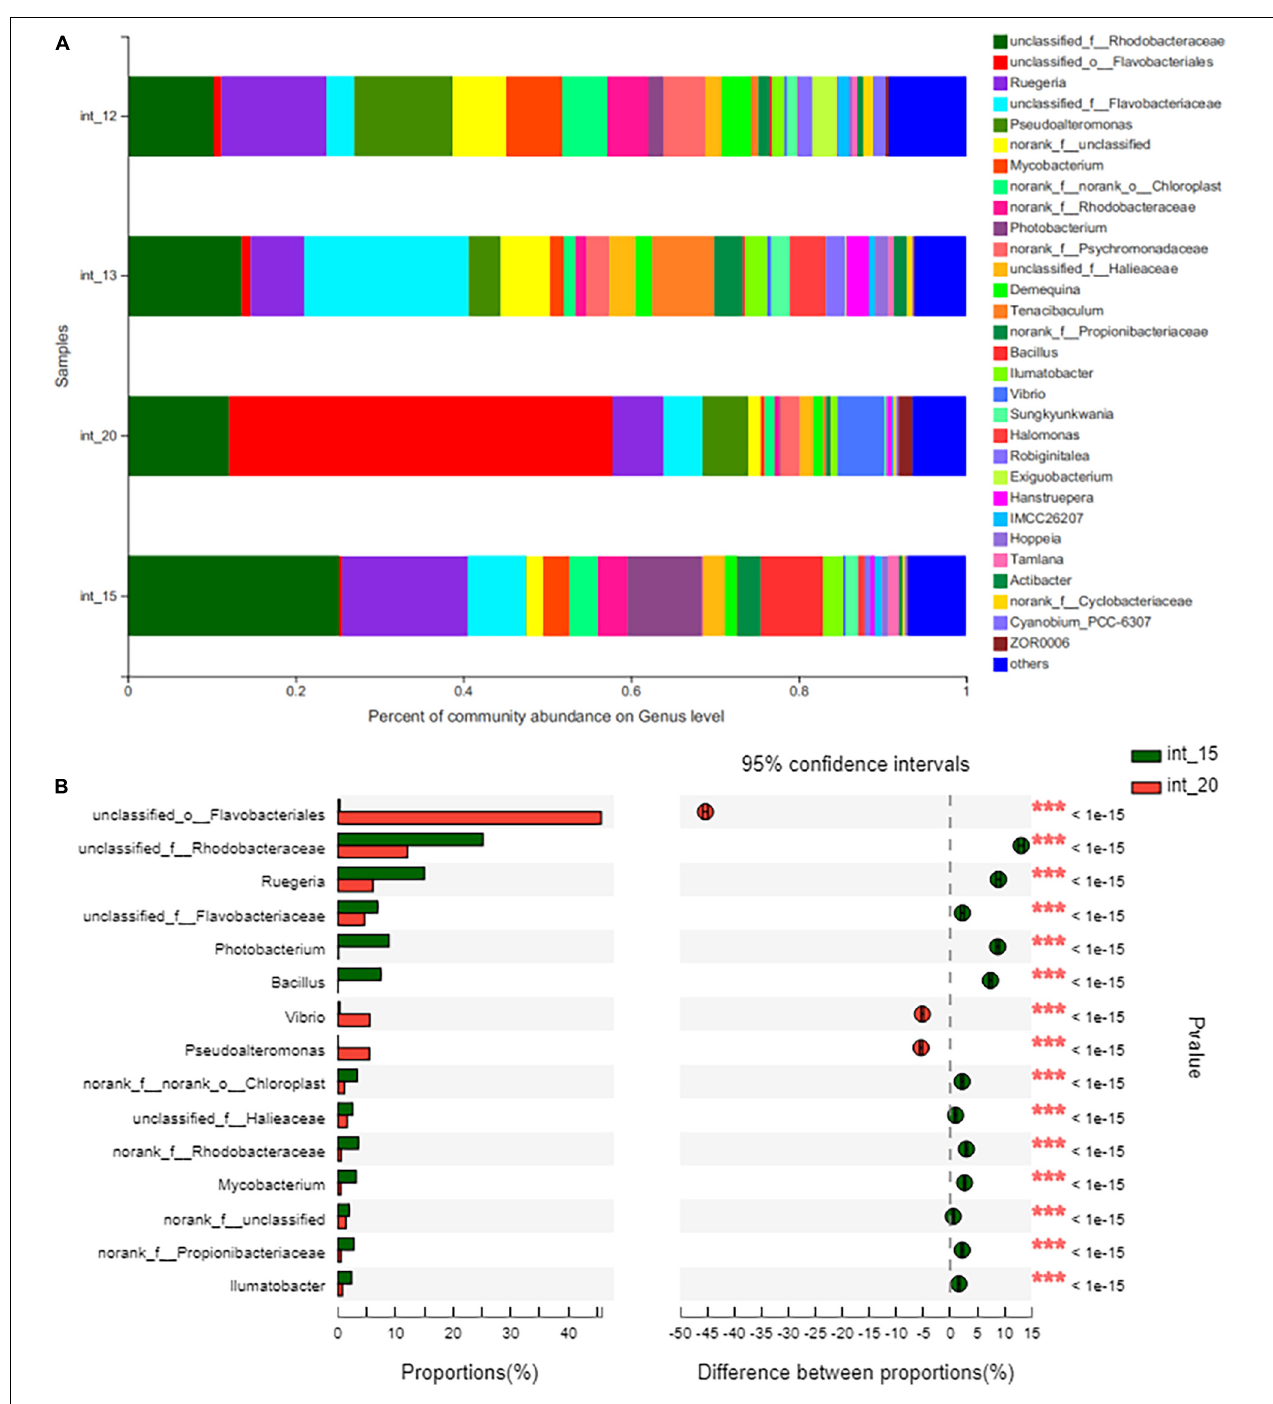
FIGURE 4 | Intestinal bacterial community of shrimps under bath challenge. The total genomic DNA from the intestine sample of the shrimps under the treatment of blank (int_12), DH82 in the first week (int_13), 17SZ then continuous with DH82 (int_15), and the 17SZ only (int_20) were respectively performed high throughput sequencing on the 16s rRNA. The taxonomy of each OTU representative sequence was analyzed by RDP Classifier version 2.2 and classified on genus level. The OTUs were analyzed by Fisher’s exact test, to compare the difference of abundance between treatments. Panel (A) is the microbial structure presented by relative community abundance, the bar plot of Bacillus is arrowed in red and that of Vibrio in blue; Panel (B) is the difference of abundance with DH82 treatment after 17SZ infection, the top 15 genera with the highest abundance were listed, including the Bacillus sp. and Vibrio sp. Statistical analysis results are presented by a significant difference indicated by *** where p ≤